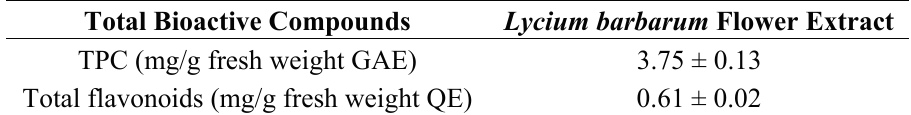
Table 2. Total content of phenolics (TPC) and flavonoids.